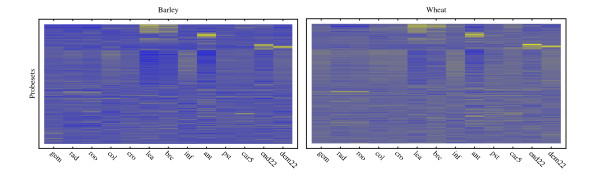
Large-scale comparison of barley and wheat transcriptome. These heat maps provide a comparative overview of gene expression for 1875 barley (left) and wheat (right) sequences. The same pattern of low (blue) and high (yellow) expression is clearly seen in both datasets. For this plot, expression profiles were centered and then sorted according to a hierarchical clustering of the barley data using single linkage and a correlation distance measure. Tissue abbreviations: gem – mesocotyl, rad – radicle, roo – root, col – coleoptile, cro – crown, lea – leaf, brc – bracts, inf – inflorescence, ant – anther, pst – pistil, car5 – caryopsis, end22 – endosperm, dem22 – embryo. Developmental time points are as described in [27] and include 2 day old embryos (gem, rad, col), 10 cm seedlings (roo, cro, lea), prior to anthesis (brc, inf, ant, pst) as well as 5 (car5) and 22 days (end22, dem22) after pollination. (see also Materials and Methods: Microarray Experiment).